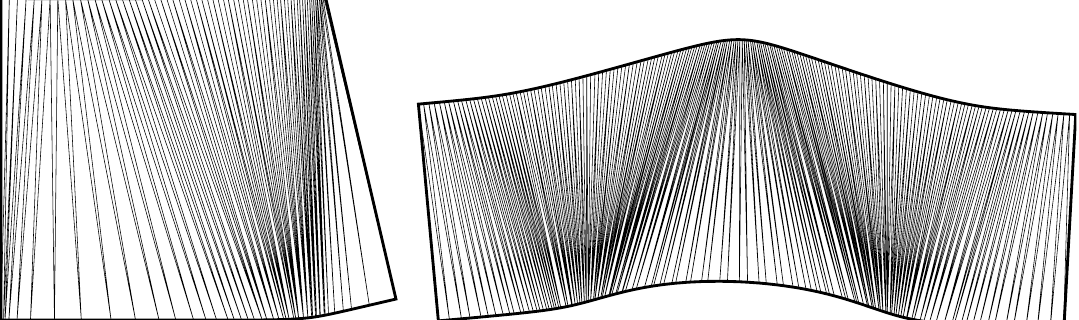
Figure 4. ‘C’ and ‘O’ shaped simple developable surfaces unrolled. Note that the ruling lines are irregular. They are neither radial nor parallel, but change direction constantly along the